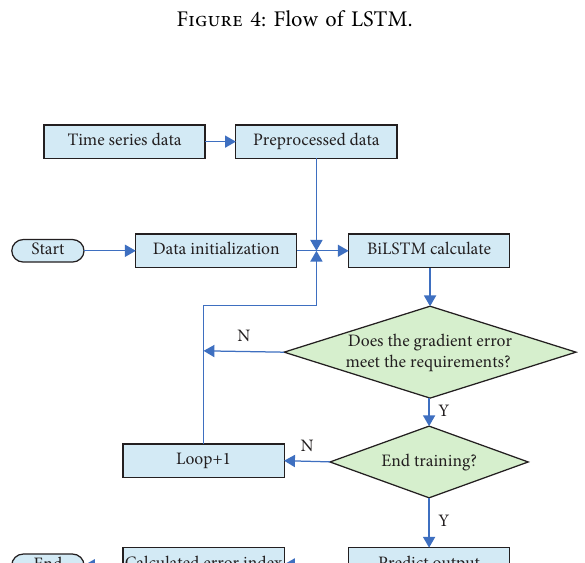
Figure 4: Flow of LSTM.